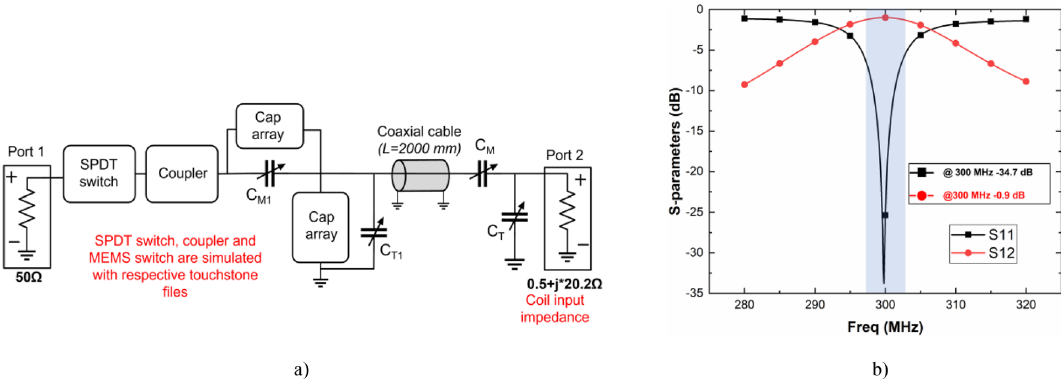
Figure 5. ( a ) Matching network simulation setup with 2 m coaxial cable to simulate remote tuning and matching and ( b ) S-parameter plot of the SWIM system modeled in